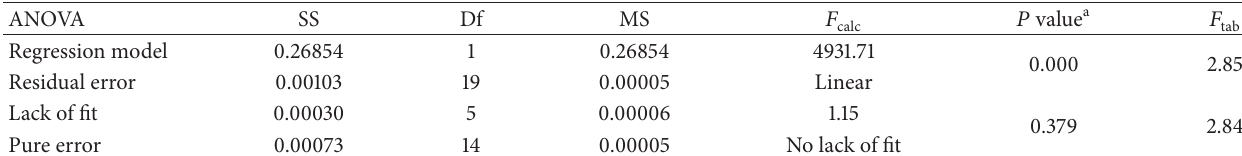
Table 4: ANOVA results for the linearity of LEV (SS: sum of squares; Df: degrees of freedom; MS: mean squares; 𝐹 calc : calculated 𝐹 test; 𝐹 tab : tabulated 𝐹 test).